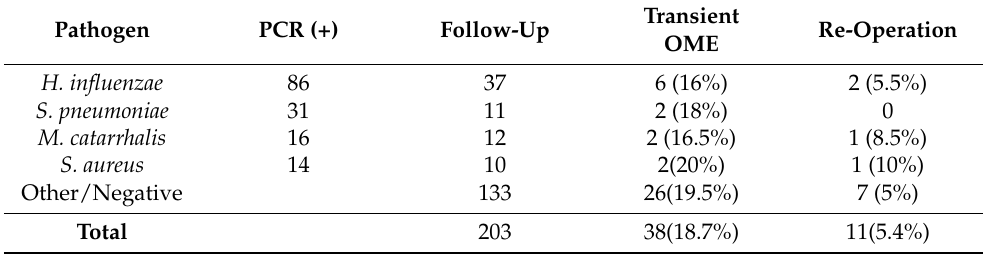
Table 5. Follow-up of COME patients.